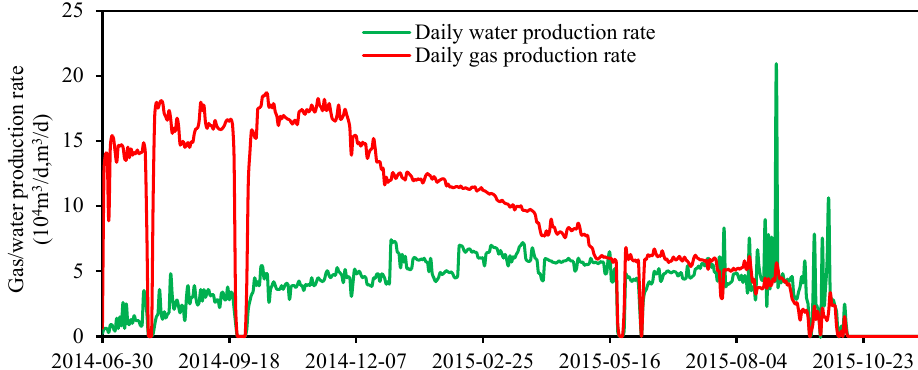
Figure 4. Production curves of well Jingnan 57-9H2.